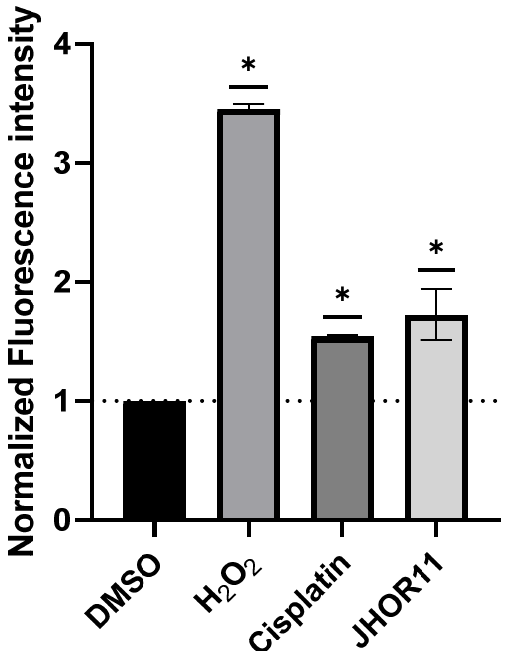
Figure 8. Production of reactive oxygen species (ROS) in A2780 after 48 h exposure to IC 50 of complex JHOR11, 0.1% ( v / v ) DMSO for vehicle control, 25 µ M H 2 O 2 and 3.5 µ M cisplatin as positive controls. Bars represent the average ± SD of at least three independent experiments of the fluorescence intensity normalized to fluorescence intensity of the vector control, represented as a dotted line. * p value < 0.05.